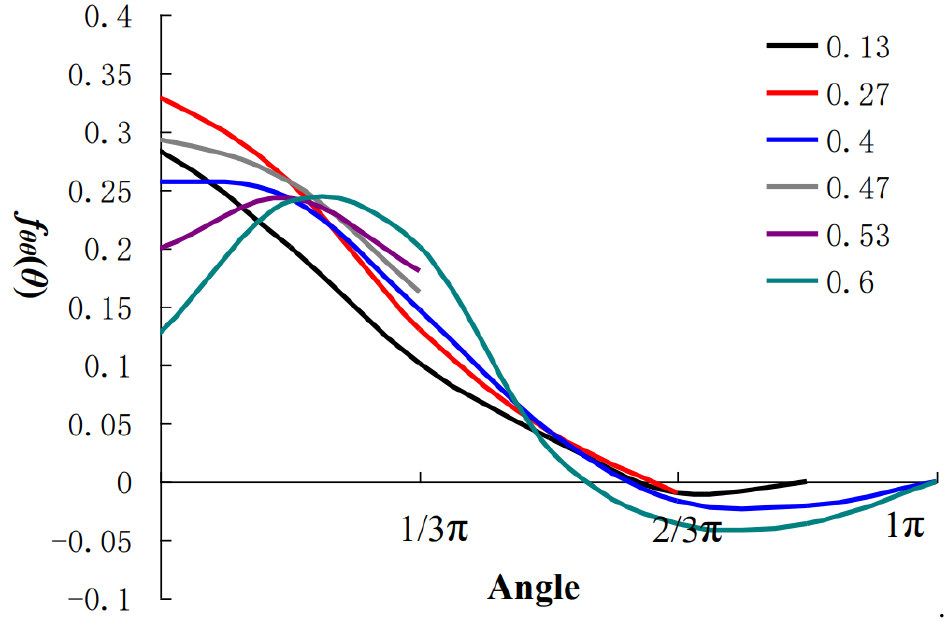
Figure 10. Variation law of angular function.